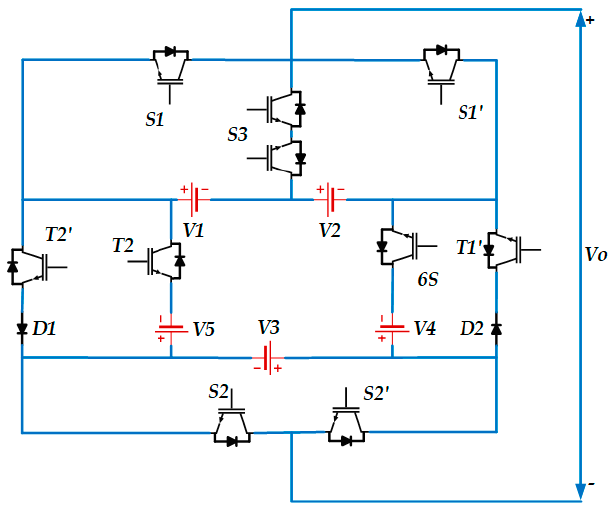
Figure 5. 23 − Level MLI.